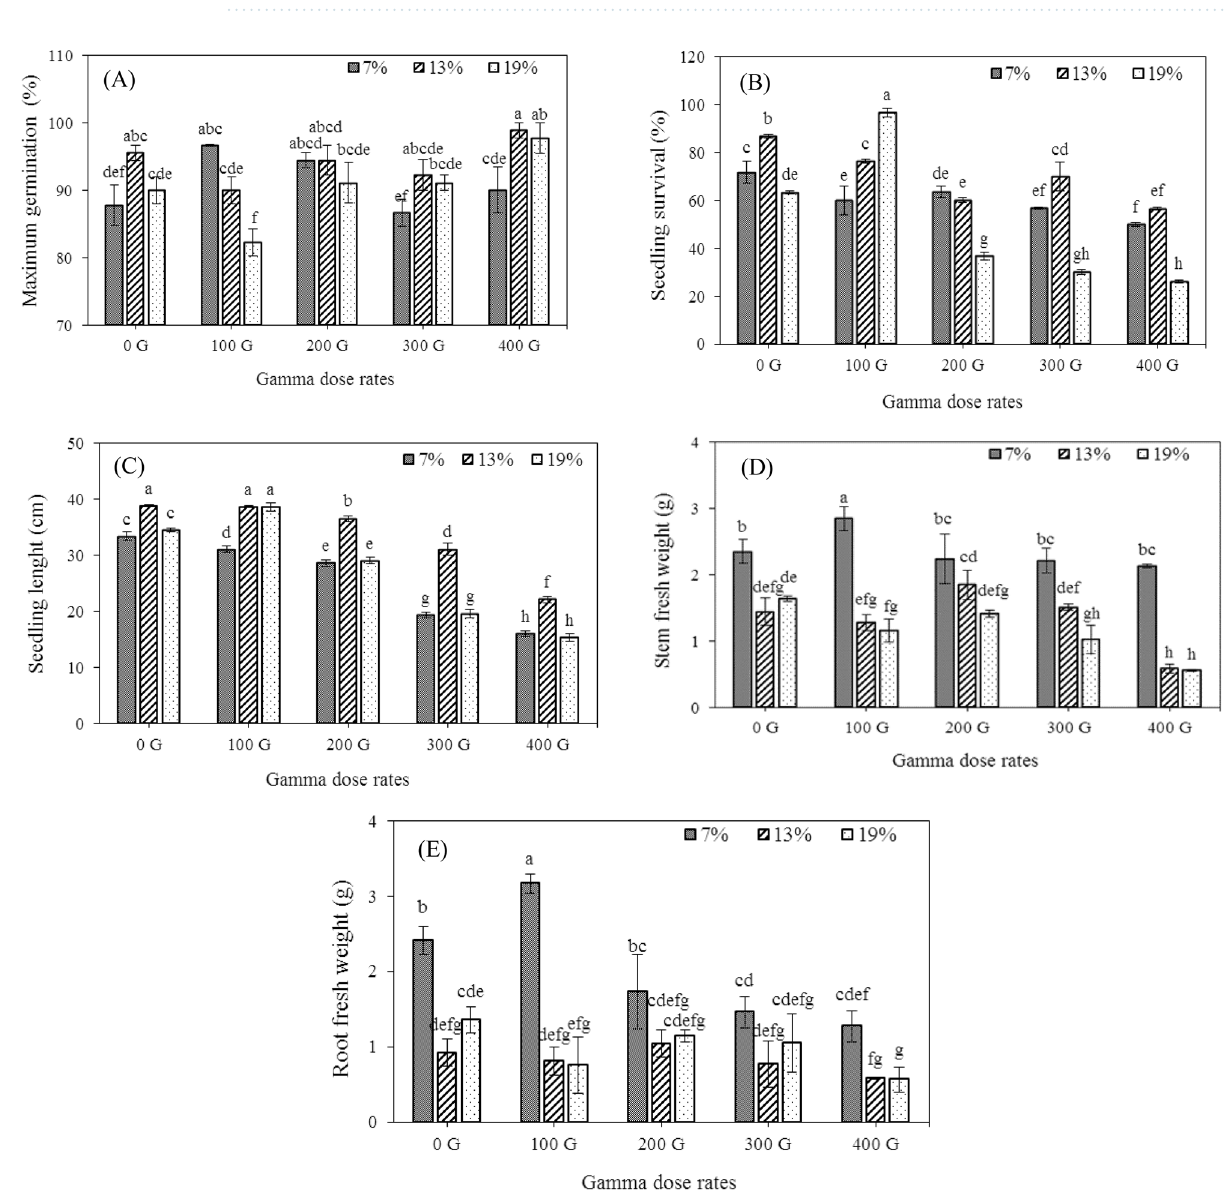
Figure 1. Effects of gamma dose rates and different seed moisture contents on maximum germination ( A ), seedling survival percent ( B ), seedling length ( C ), stem fresh weight ( D ), root fresh weight ( E ). Each bar represents mean ± SE (n = 3). Mean values marked with different letters are significantly different (p ≤ 0.05) by LSD